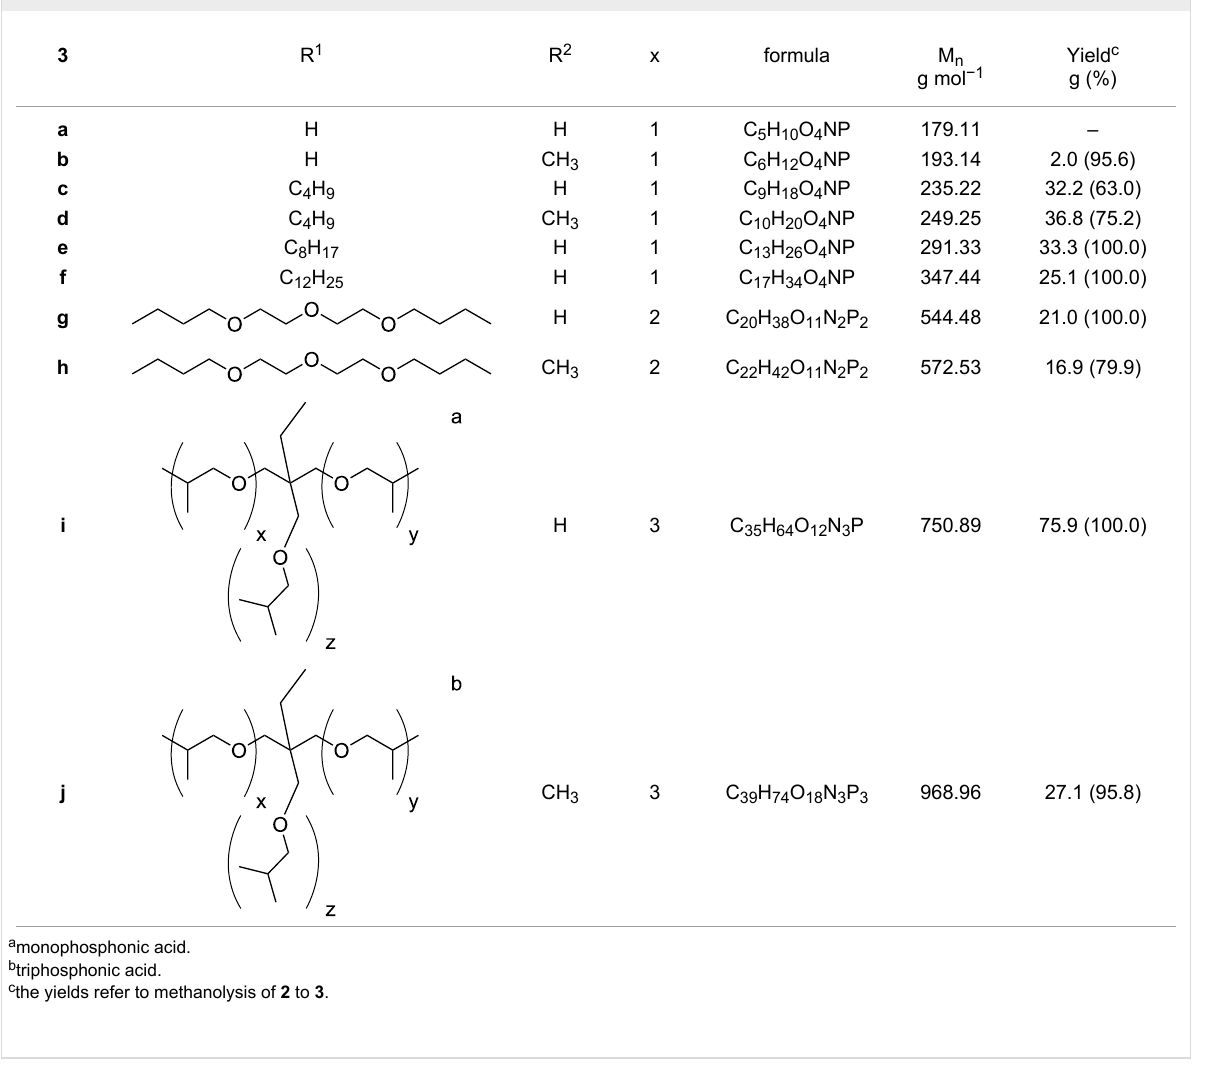
Table 1: Formula, M n -values and yields of N -alkyl- N -(phosphonoethyl) (meth)acrylamides 3 .